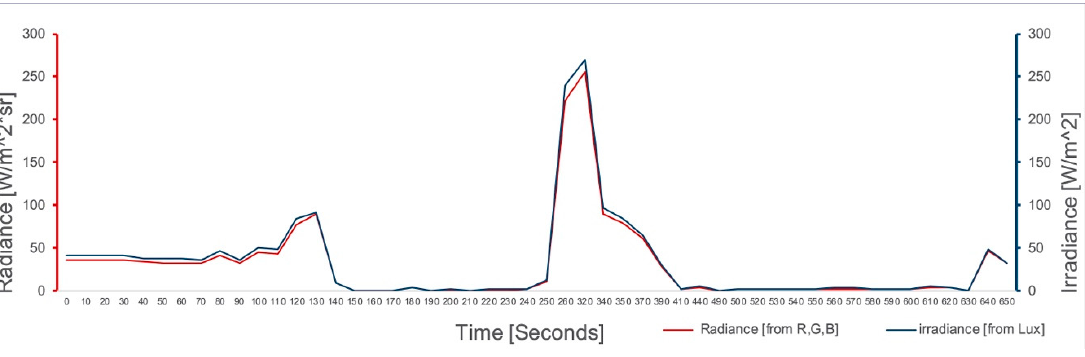
Figure 9. Approximation of solar radiation with RGB and lux sensor.